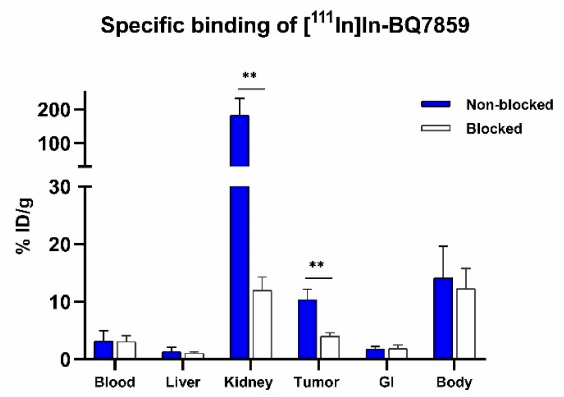
Figure 9. In vivo specificity of [ 111 In]In-BQ7859 1 h post-injection in PSMA-expressing PC3-pip tumour-bearing mice. To block PSMA, 5 nmol non-labelled PSMA-11 was used. ** indicate p -value < 0.01. Statistical analysis was done using an unpaired, two-tailed t